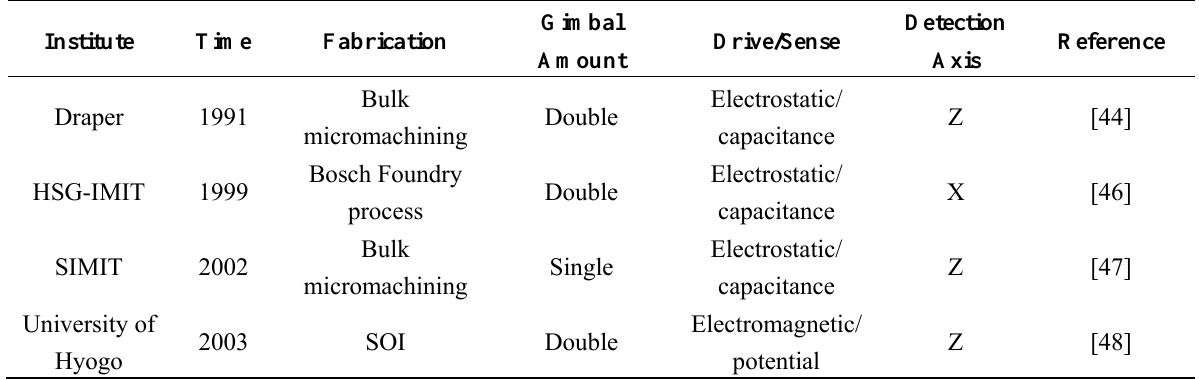
Table 4. The summary of decoupled